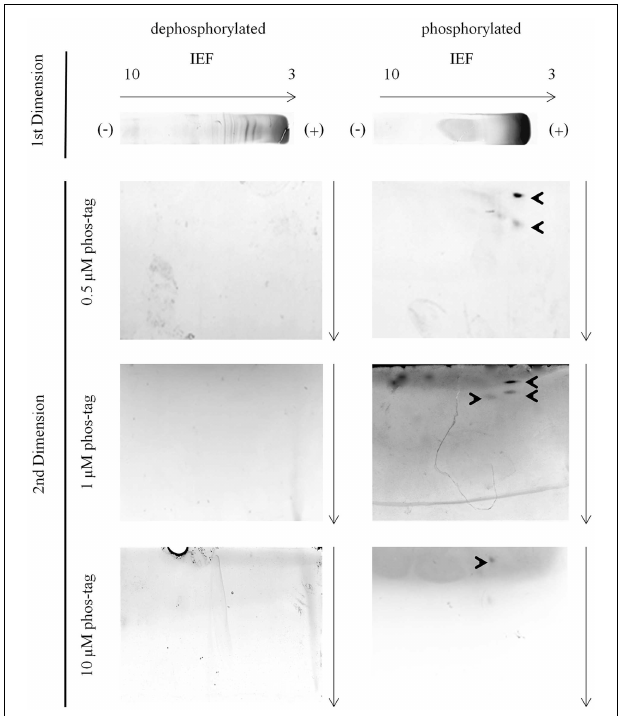
FIGURE 3 | Phosvitin separation—IEF/hrCNE vs. IEF/phos-tag hrCNE. Phosvitin (phosphorylated and partially dephosphorylated) was separated in the first dimension non-reducing IEF specified on the top of the figure. hrCNE 4–16% or phos-tag hrCNE 4–16% were accomplished in the second dimension. The indicated phos-tag concentrations (0.5, 1.0 and 10 µ M) were chosen based on former results of Deswal et al. (2010). The pH of the IEF (3–10) is indicated on the top of the first dimension. Arrows show the direction of protein separation. Cathode and anode are indicated as ( − ) and ( + ), respectively.